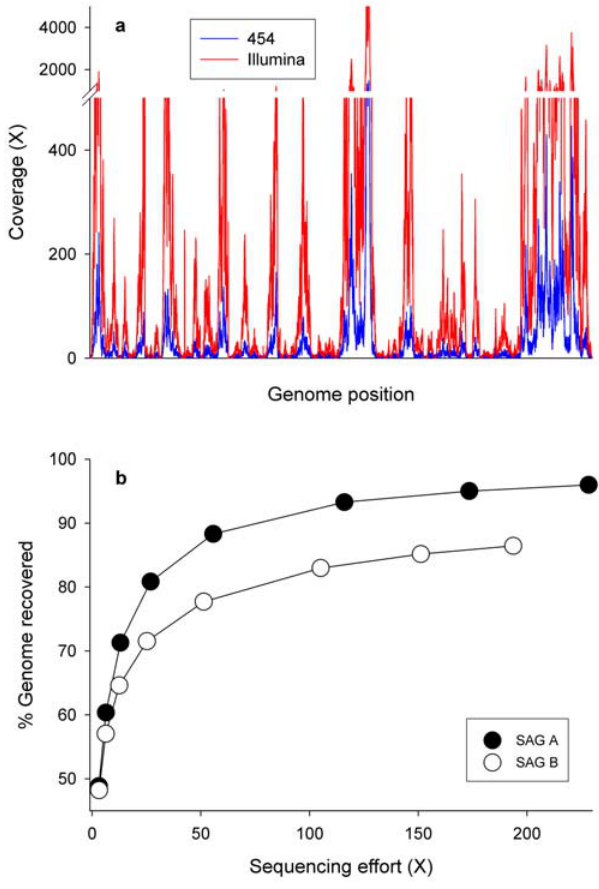
Figure 1. Sequencing coverage after WGA of individual Prochlorococcus cells. A) Average fold-coverage within 100 bp windows was determined for SAG A from the alignment of 454-FLX read data (blue) and Illumina read data (red) to the Prochlorococcus MED4 reference genome. B) Genome recovery for individual Prochlorococcus cells, SAG A and SAG B, as a function of sequencing effort for Illumina libraries (35 nucleotide read lengths). Each datapoint represents the mean genome recovery from at least two reference-guided assemblies. Standard deviations are too small to be visible on the figure.